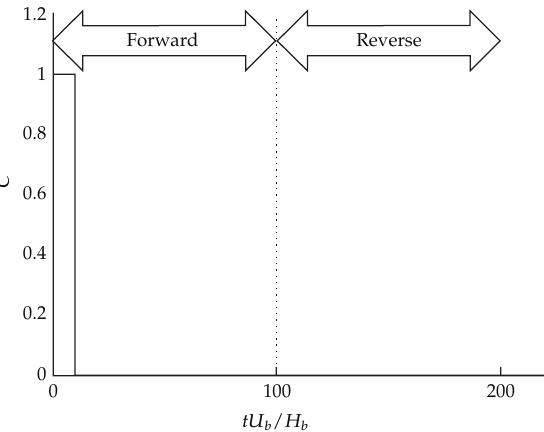
Figure 2: Emission time and analysis time, forward analysis time: 0 ∼ 100, reverse analysis time: 100 ∼ 200. U b refers to the velocity at H b